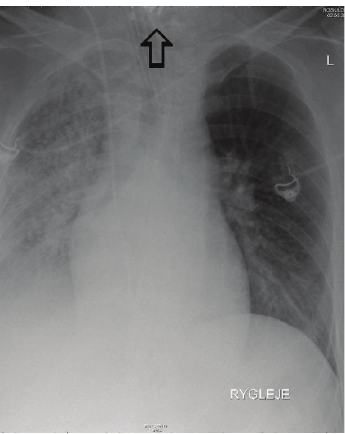
Figure 1: Chest X-ray 6 months prior to admittance to our depart- ment. Severe right-sided pneumonia and a suspected foreign object in the oesophagus.